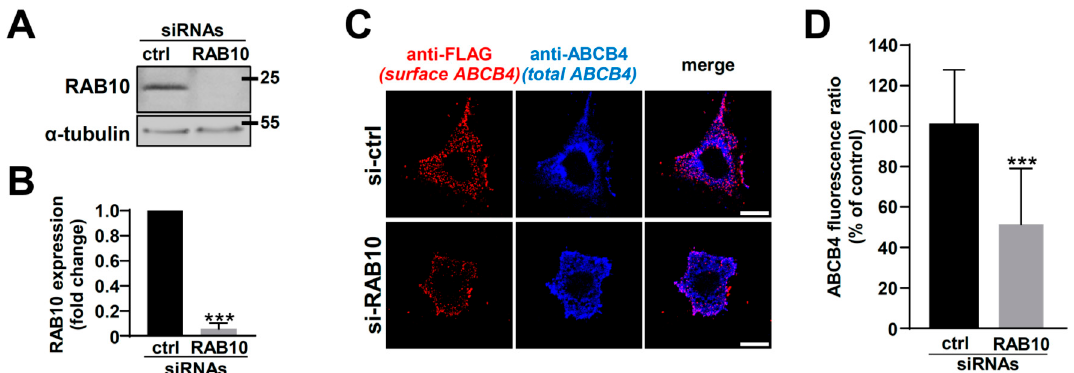
Figure 4. Effect of RAB10 knockdown on ABCB4 localization in HeLa cells. ( A ) Forty-eight hours after siRNA transfection in HeLa cells (Control, ctrl or anti-RAB10), RAB10 expression was analyzed by immunoblot, as in Figure 2A. This panel is representative of three independent experiments. The presented data were cropped from full immunoblots shown in Supplementary Figure S7. ( B ) Densitometry analysis of (A), as performed in Figure 2B. Means (±SD) of at least three independent experiments are shown; *** p < 0.005. ( C ) HeLa cells treated as in (A) were used to analyze ABCB4-FLAG localization at the plasma membrane, as performed in Figure 3B. This panel is representative of three independent experiments. Bars: 10 µm. ( D ) Quantification of (C), as performed in Figure 3C. Means (±SD) are represented; *** p < 0.005.